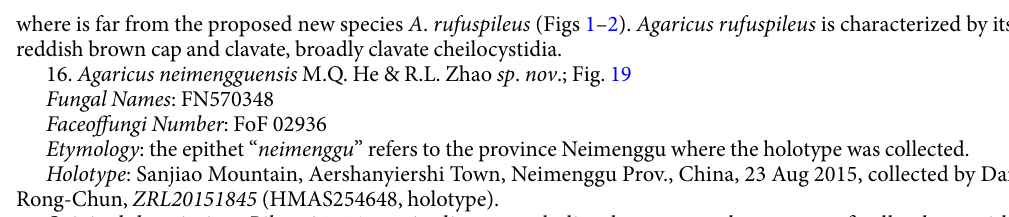
16. Agaricus neimengguensis M.Q. He & R.L. Zhao sp . nov .; Fig. 19 Fungal Names : FN570348 Faceoffungi Number : FoF 02936 Etymology : the epithet “ neimenggu ” refers to the province Neimenggu where the holotype was collected. Holotype : Sanjiao Mountain, Aershanyiershi Town, Neimenggu Prov., China, 23 Aug 2015, collected by Dai Rong-Chun, ZRL20151845 (HMAS254648, holotype). Original description: Pileus 25–71 mm in diam., parabolic when young, then convex, finally plane, with umbo at disc; margin entire, slightly exceeding and appendiculate when young; surface dry, covered by fibrils at the whole cap; forming tiny fibrillose scales at disc, brown or reddish brown, triangular, appressed, then fading towards the margin. Context 2–6 mm thick, flesh, white, gray. Lamellae 2–4 mm broad, free, crowded, pink or pinkish brown firstly, then brown, edge even, narrow to broad, intercalated with lamellulae. Annulus 2–4 mm in diam., single, membranous, smooth on both sides, pendant, persistent, white, turning yellow when dry or old. Stipe 42–82 × 5–7 (5–8 at base) mm, white, hollow, long cylindrical, surface dry, above the annulus smooth, below slightly fibrillose. Odour of bitter almonds or aniseed. Basidiome flavescent immediately, then orange brown after few minutes when touching, bruising and cutting. KOH reaction: positive yellow. Schäffer’s reaction: positive, reddish orange on dry specimen. Basidiospores 5.0–6.1 × 3.4–4.2 μ m, [x = 5.5 ± 0.3 × 3.8 ± 0.2, Q = 1.4–1.5, Q m = 1.5 ± 0.0, n = 20], ellipsoid, smooth, thick-walled, brown. Basidia 15.2–21.9 × 6.4–8.4 μ m, clavate, hyaline, 4-spored, smooth. Cheilocystidia 17.1–42.0 × 8.2–24.7 μ m, smooth, clavate mostly, broadly clavate, hyaline, rarely clavate, occasionally 1-sepat at the base, always containing yellow pigments. Pleurocystidia absent. Pileipellis a cutis composed of hyphae of 4.6– 7.6 μ m in diam., smooth, cylindrical, brown, slightly constricted at some septa. Habitat : solitary on soil in forest. Other specimens examined : Sanjiao Mountain, Aershanyiershi Town, Neimenggu Prov., China, 23 Aug 2015, collected by Dai Rong-Chun, ZRL20151831 (HMAS275799); same location, 23 Aug 2015, collected by Li Guo-Jie, ZRL20151841 (HMAS280111); Honghuaerji Natural Reserve, Hu Lunbeier, Neimenggu Prov., China, 22 Aug 2015, collected by Li Guo-Jie, ZRL20151815 (HMAS275800).